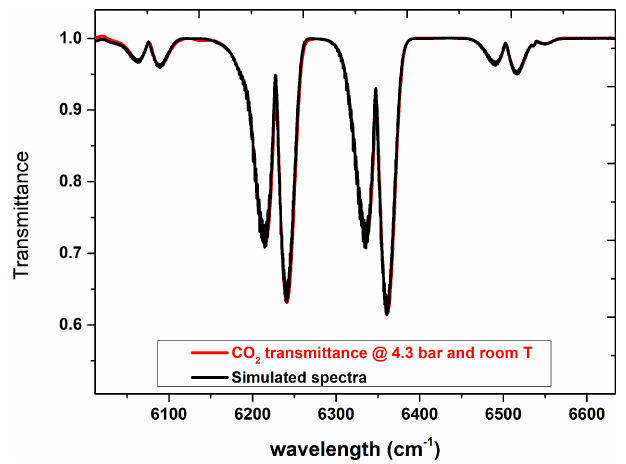
Figure 9. Comparison of acquired CO 2 spectra at room temperature with 4.3bar (red curve) and as simulated (black curve).